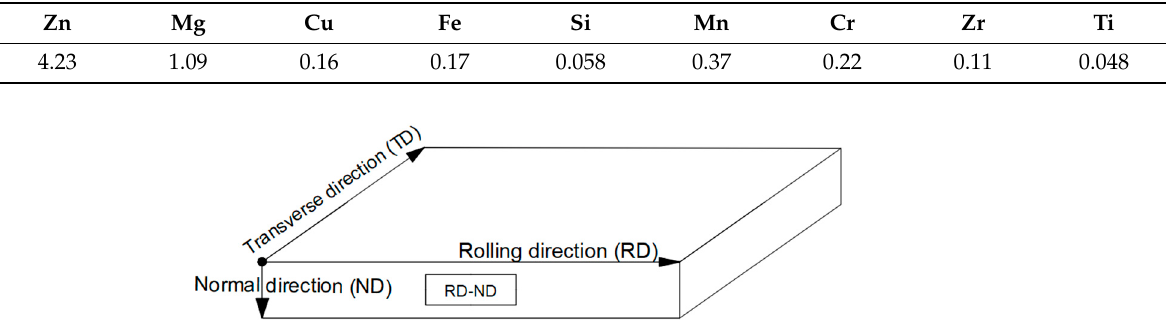
Figure 1. Schematic diagram of sampling location in a cast-rolled sheet.